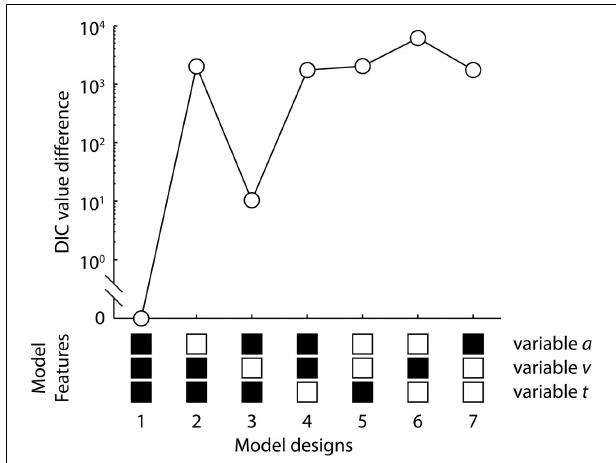
FIGURE 4 | The deviance information criterion (DIC) value differences between the seven variants of the drift-diffusion model and the best model. The models differ on whether the boundary separation a , mean drift rate v , and mean non-decision time T er can vary between the speed and accuracy conditions. The model structures are shown below the figure. The black square indicates that the corresponding parameter can vary between the speed emphasis and accuracy emphasis conditions, and the white square indicates that the parameter is invariant between the two task conditions. The best model with the minimum DIC value had variable a , v , and T er (model 1, DIC =